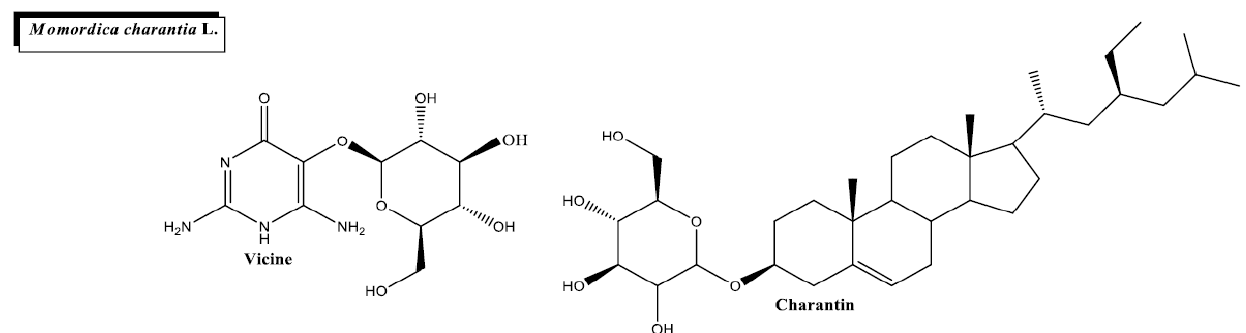
Figure 8. Chemical structures of bioactive phytocompounds with reported antidiabetic properties identified in Momordica charantia L.